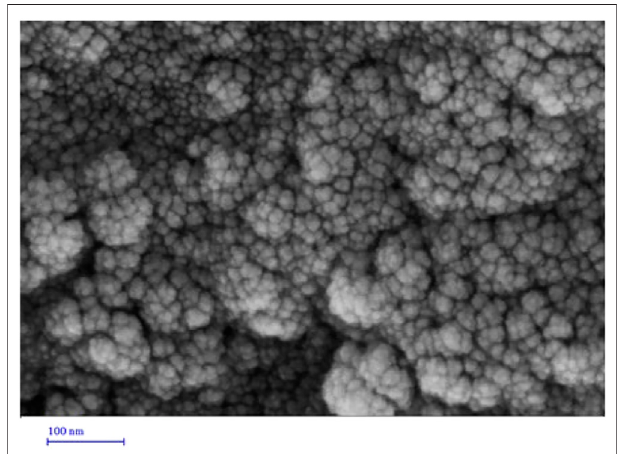
FIGURE 2 | Morphological characterization of optimized niosomes by SEM.